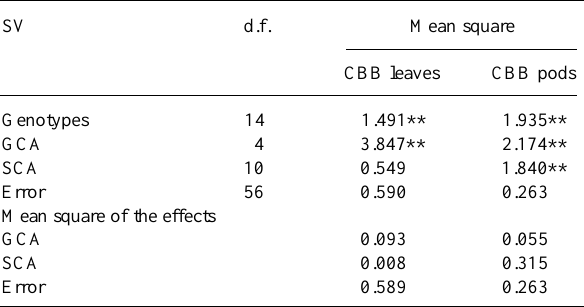
Table III - Estimates of the mean squares among the Phaseolus vulgaris L. genotypes (parents and their F1 hybrids of the diallel), the general and specific combining abilities (GCA and SCA) and the error variance and the estimates of the square values of the mean combining ability effects and error variance for reaction to common bacterial blight (CBB) in leaves and pods, according to method 2, model 1 of Griffing (1956).